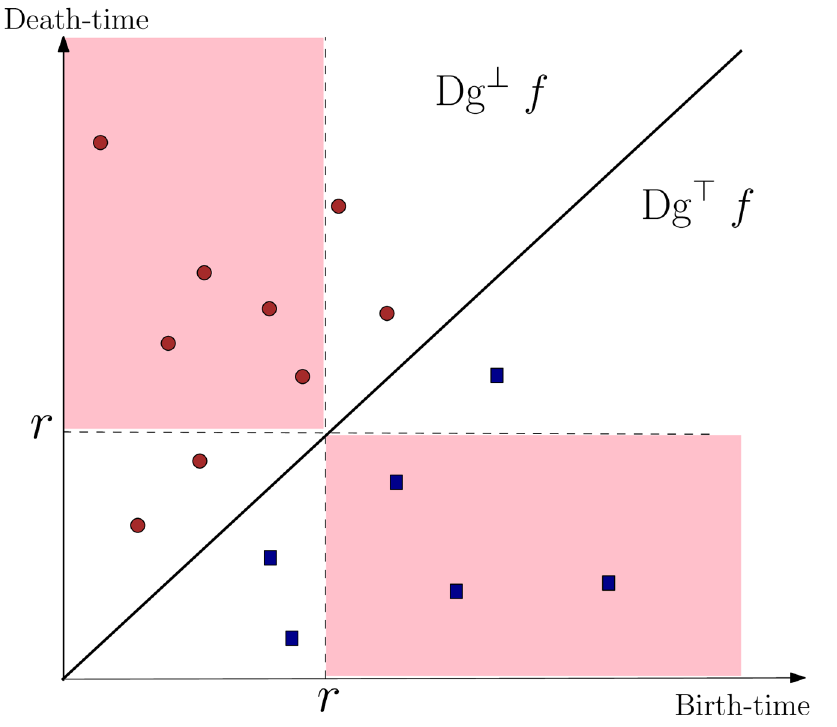
Fig 6. Illustration for relation between Sholl count and persistence diagram. Solid disks are points in Dg ? f whilesquaresare points in Dg > f . N ( r ) equalsto the numberof points in the two shadedquadrants minus one (to correct for doublecounting of the root node). For the r value shown in the picture, N ( r ) = 7.